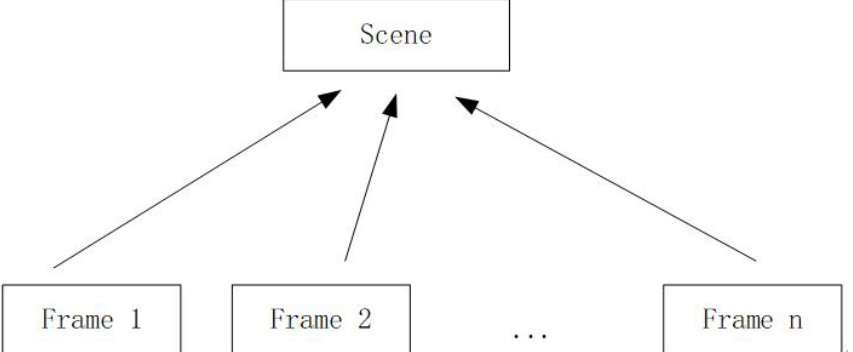
Figure 6. The process of